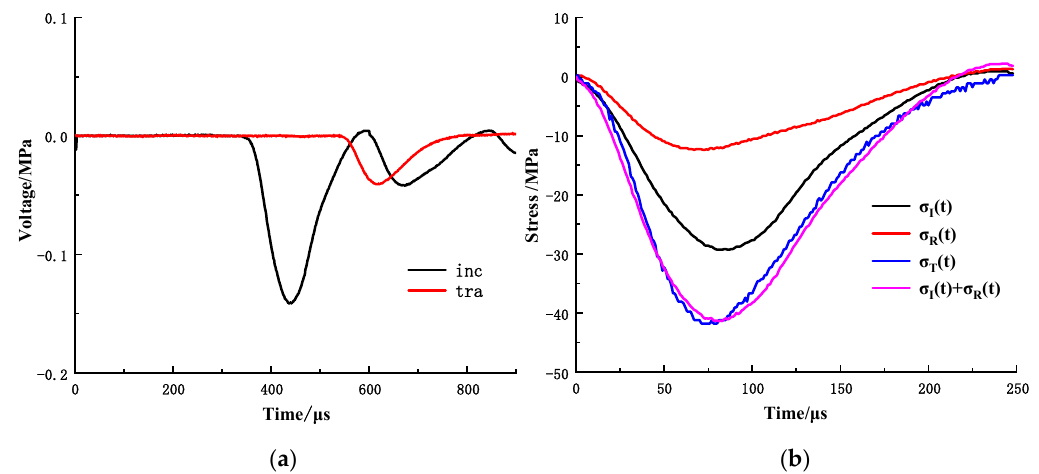
Figure 5. Stress-balance check of MP-A4-T2: ( a ) Waveform signal of MP-A4-T2; ( b ) Stress balance diagram of MP-A4-T2.